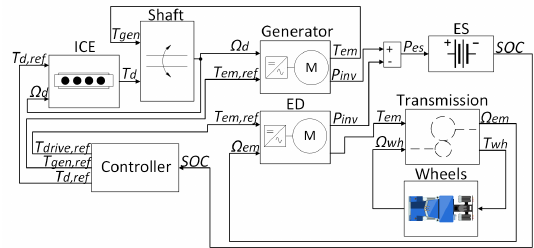
Figure 2: Layout example of series hybrid